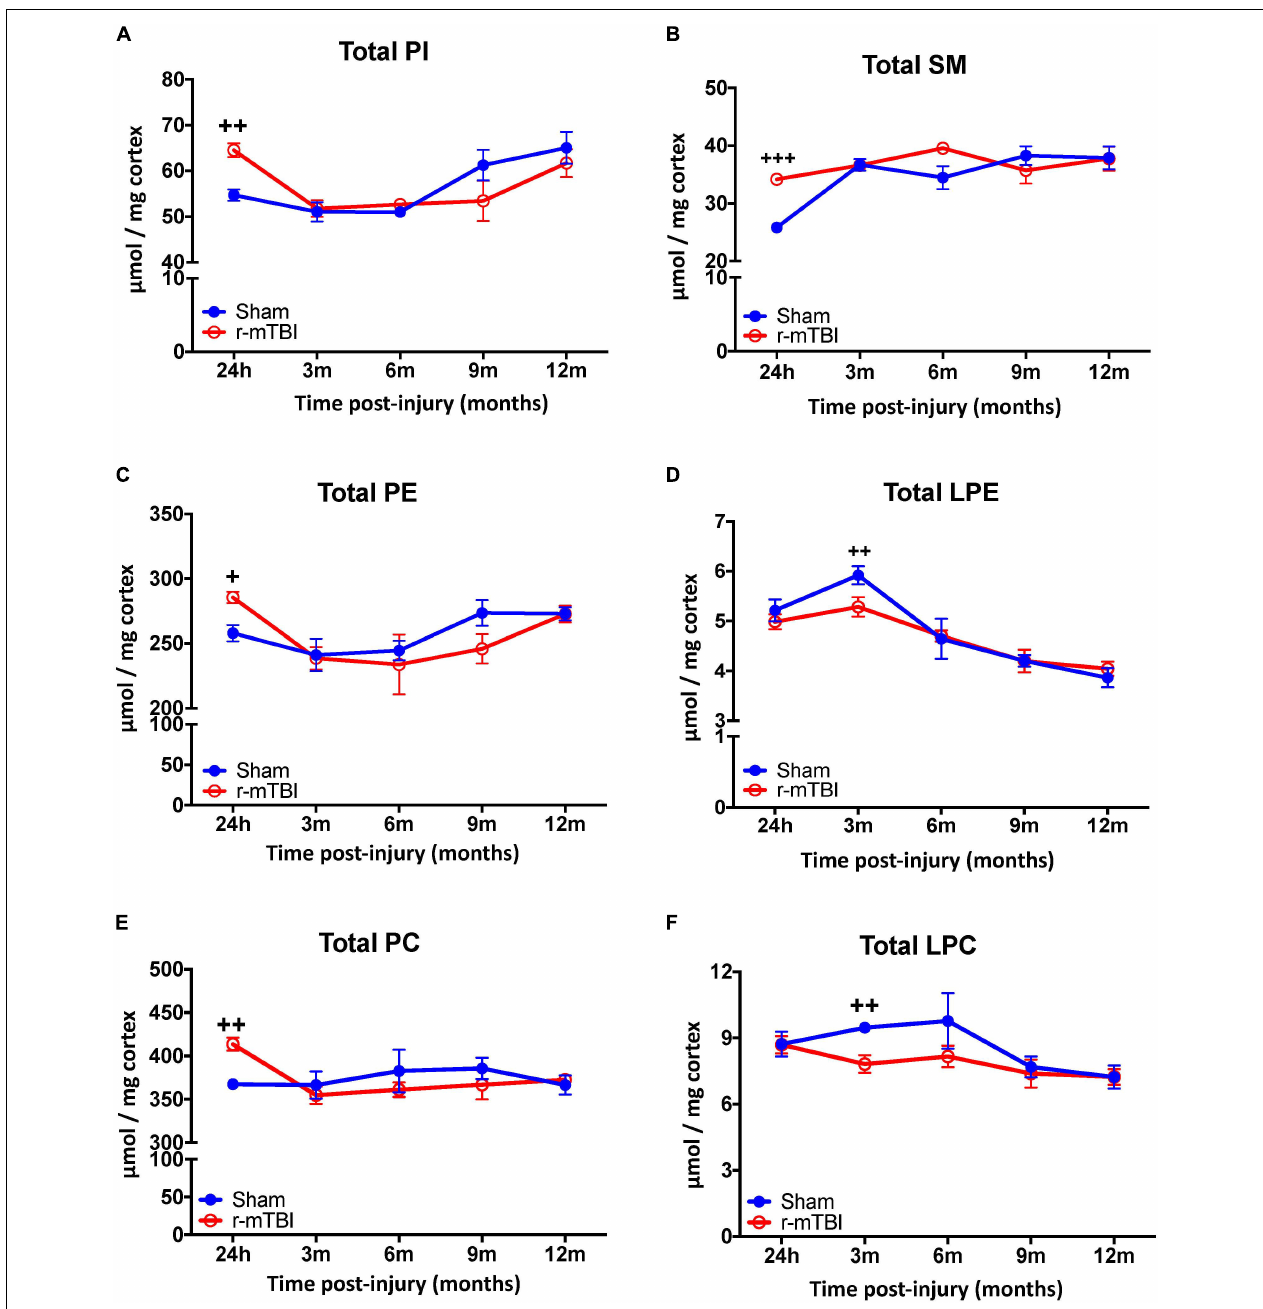
FIGURE 1 | Total Phospholipid levels in the cortex of r-mTBI hTau mice. Significant changes in total phospholipid [PI (A) , SM (B) , PE (C) , LPE (D) , PC (E) , LPC (F) ] species in the cortex of a model of repetitive-mTBI in hTau mice. Sample size for all groups across all time points is n = 4. All data represent mean µ M per (10 mg) wet weight ± SEM. Individual molecular lipid species were quantified by liquid chromatography/mass spectrometry and were summed after LipidomeDB analyses to generate total phospholipid levels. Asterisks represent + P < 0.05, ++ P < 0.01, +++ P < 0.001 for comparisons between sham/r-mTBI mice.